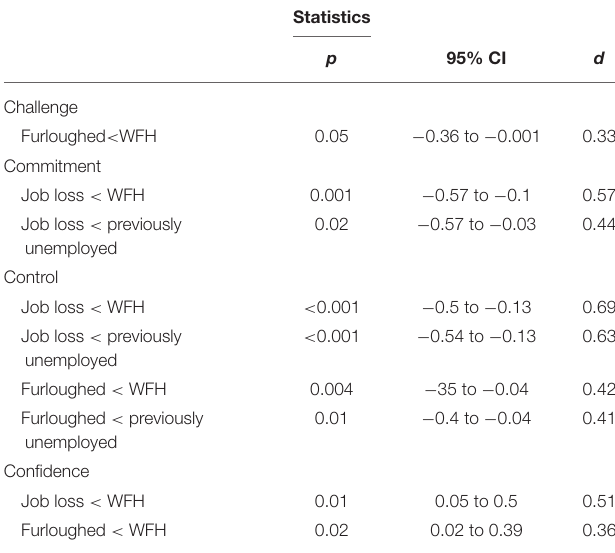
TABLE 7 | Significant post–hoc comparisons for job outcome and